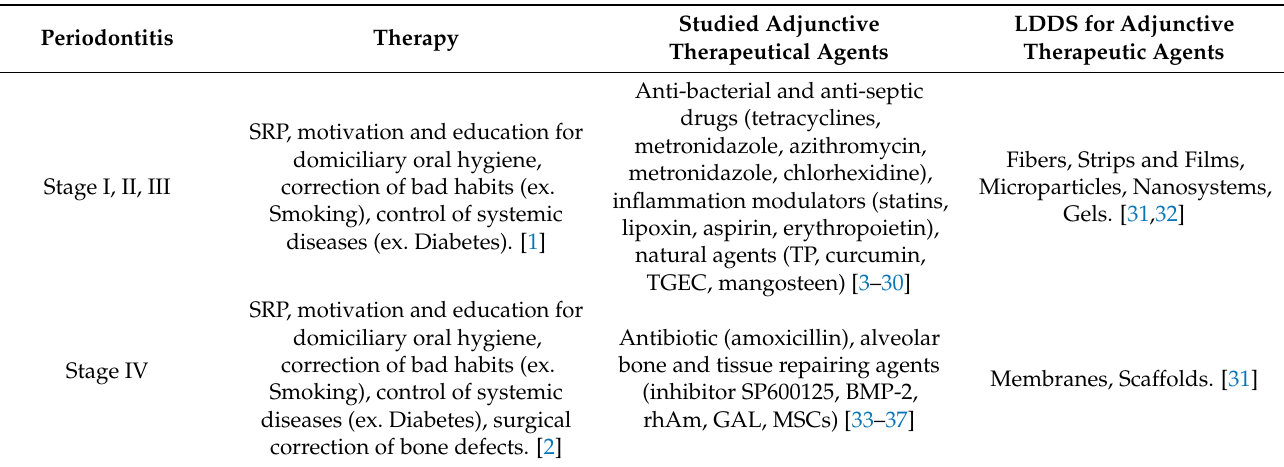
Table 1. Stages of Periodontitis with associated therapy and the studied adjunctive therapeutical agents with relative